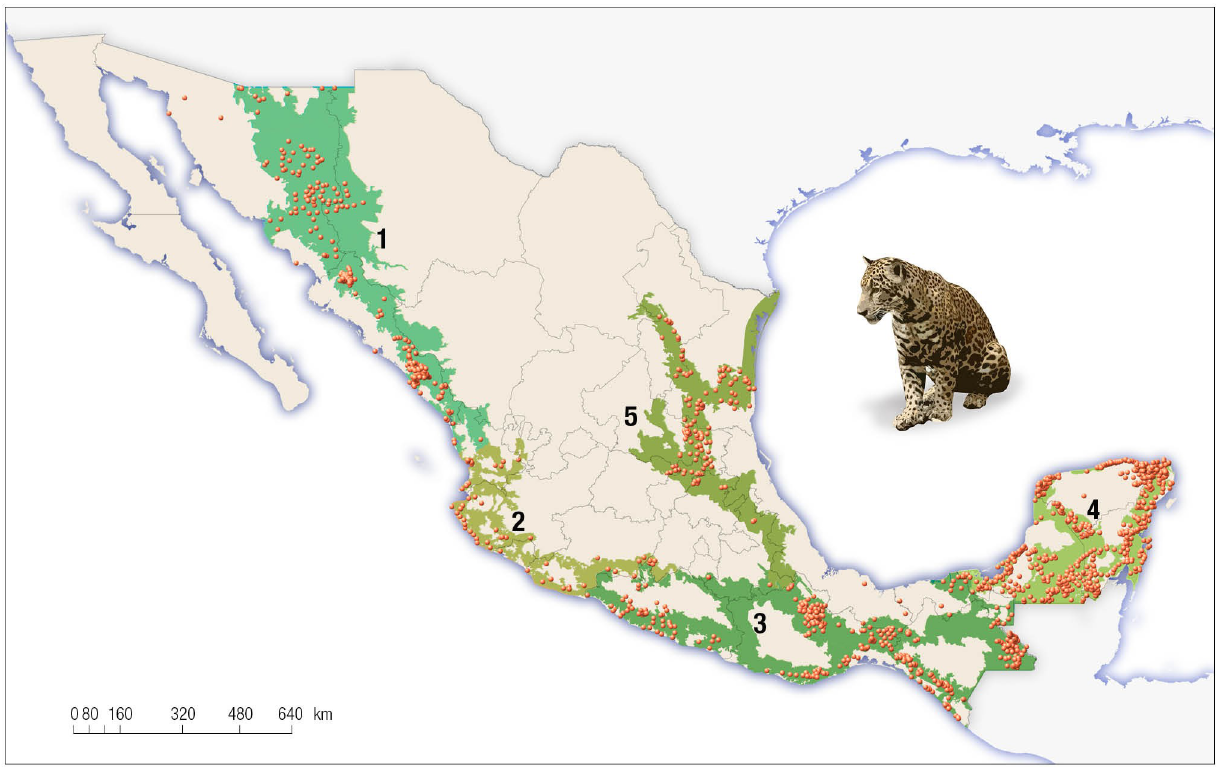
Fig 1. Current geographic range of jaguar ( Panthera onca ) in Mexico (green, Ceballos et al. 2018 [58]) and records in the last 20 years.